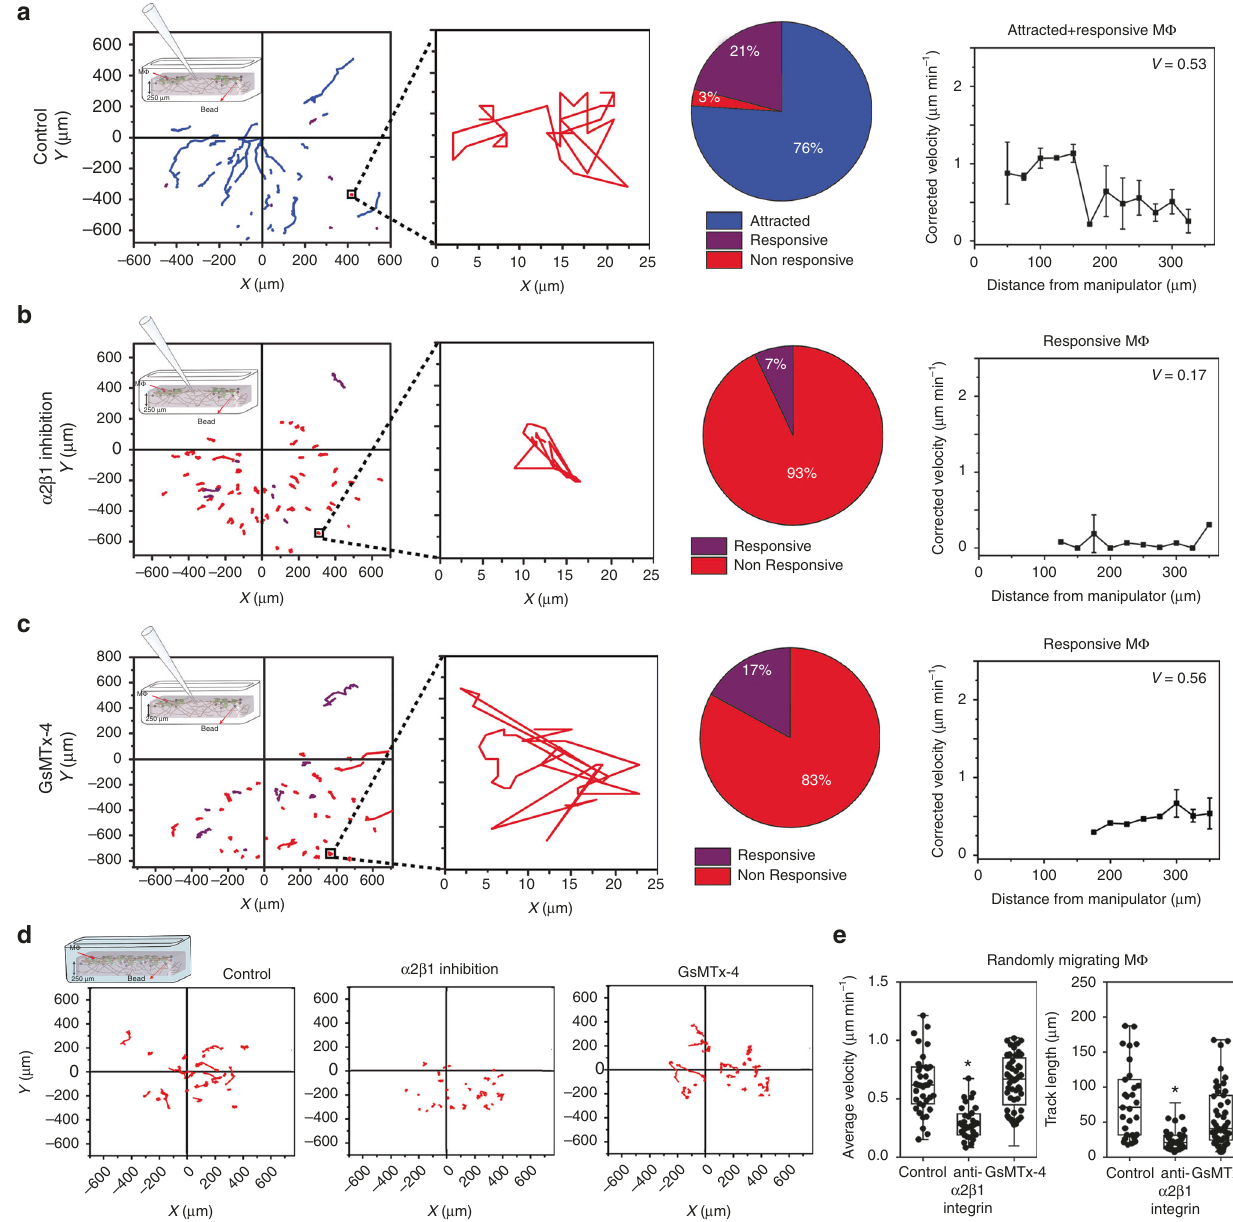
Fig. 8 Macrophage (M ϕ ) mechanosensation mechanisms on fi brillar collagen extracellular matrix (ECM). a M ϕ were seeded onto 250- µ m-thick collagen ECM with surface marker beads and overlaid with a 20- µ m-thin fi lm of polymerized collagen before inserting a microneedle 5 µ m into the 270- µ m-thick collagen gel. Lateral collagen deformation, mimicking myo fi broblast contraction, was achieved by sucking collagen fi bers into the tip using negative pressure. M ϕ migration was tracked from phase-contrast movies and tracks are plotted with respect to the position of the microneedle (0,0). Individual representative tacks are zoomed to discriminate between local migration and immobility. M ϕ migration is classi fi ed into attracted, responsive, and non- responsive M ϕ without treatment in pie charts (44 M ϕ , 3 experiments). Median values of corrected velocities of attracted M ϕ are plotted as a function of distances to the microneedle tip with error bars representing minima and maxima. b Same experimental set-up and analysis as in a but in the presence of α 2 β 1 integrin blocking antibody (10 µ g ml − 1 ) (60 M ϕ , 3 experiments). c Same experimental set-up and analysis as in a but in the presence of stretch- sensitive ion channel blocker GsMTx-4 (3 µ M) (46 M ϕ , 3 experiments). d Same experimental set-up and analysis as in a – c but without micromanipulator. e Average local migration velocities and track lengths of randomly migrating (no stimulus) M ϕ are compared between control ( n = 39), α 2 β 1 integrin inhibition ( n = 31), and GsMTx-4 ( n = 53). Shown are medians ± value ranges (* p ≤ 0.05 using analysis of variance followed by post-hoc Tukey ’ s multiple comparison